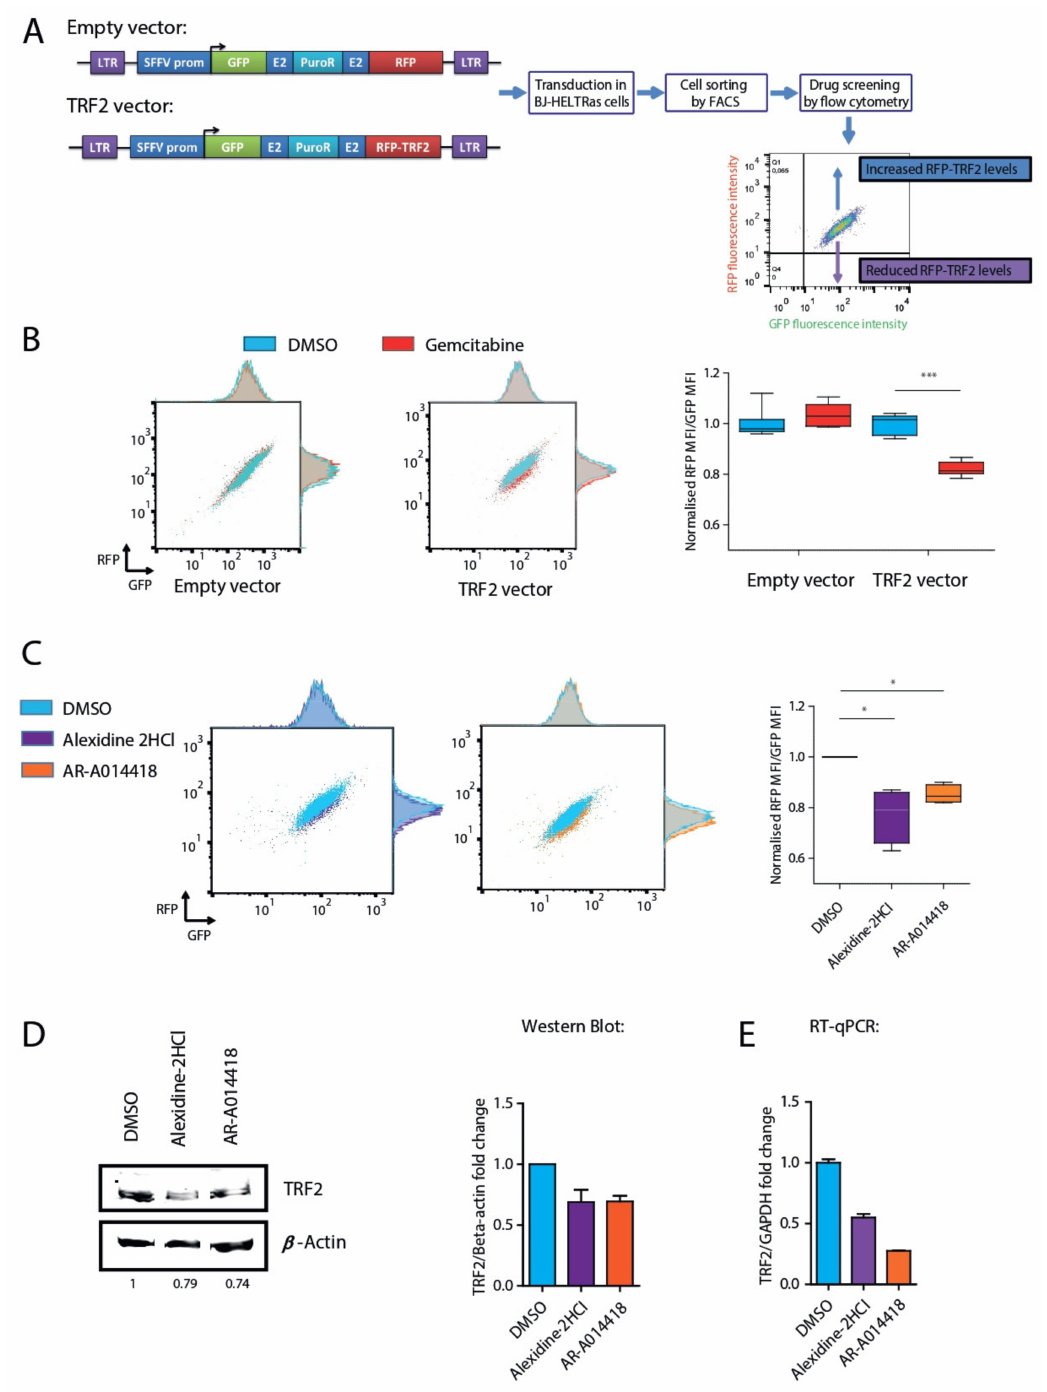
Figure 1. Identification of drugs that affect TRF2 expression using fluorescence-based drug screening. ( A ) Schematic representation of the drug screening experimental design. Lentiviral constructs that contained a poly-cistronic gene encoding green fluorescent protein (GFP) and either red fluorescent protein (RFP) alone (empty vector) or a fusion of RFP protein at the N-terminal region of TRF2 (TRF2 vector) were transduced into the BJ-HELTRas cell line. Clones sorted using fluorescence-activated cell sorting (FACS) were then used to screen for drugs that modified TRF2 protein levels. ( B ) Proof of concept using the TRF2-regulating drug gemcitabine as a positive control. Representative RFP/GFP flow cytometry density plots of empty vector- or TRF2 vector-transduced BJ-HELTRas cells treated with either DMSO or gemcitabine (10 µ M) (left panel). Box-plot quantification of RFP (empty vector) or RFP-TRF2 fusion (TRF2 vector) protein after treatment with